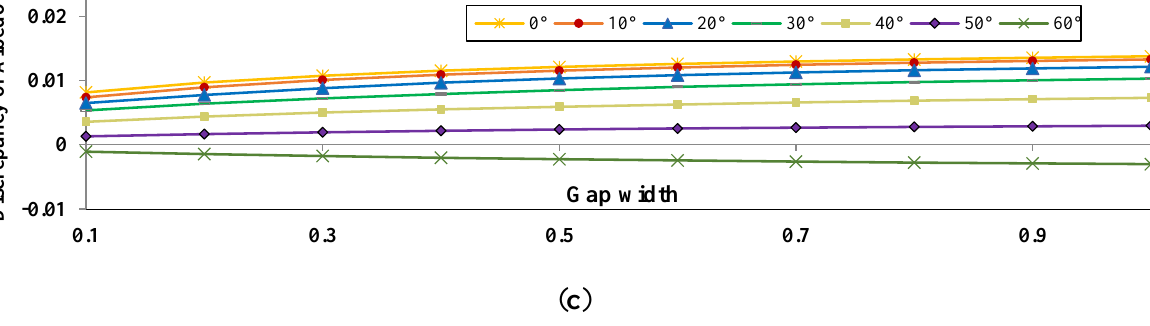
Figure 8. The discrepancy between albedo derived from the isotropy and anisotropy soil models. ( a , b , c ) the discrepancy of albedo varying with the LAI,  and the gap width of  . The default values include  = 0.23, A 1 = 0.3, crops. Each line corresponds to a certain s l H = 1,  =90° (perpendicular to the ridge). ( a ) 0.2  , A 2 = 0.2, LAI was varied from 0.1 to nine. ( b ) LAI = 2, A 2 = 0.2,  was varied from 0.1 to one. ( c ) LAI = 2, 0.2  , the gap width ( A 2 ) was varied from 0.1 to one.